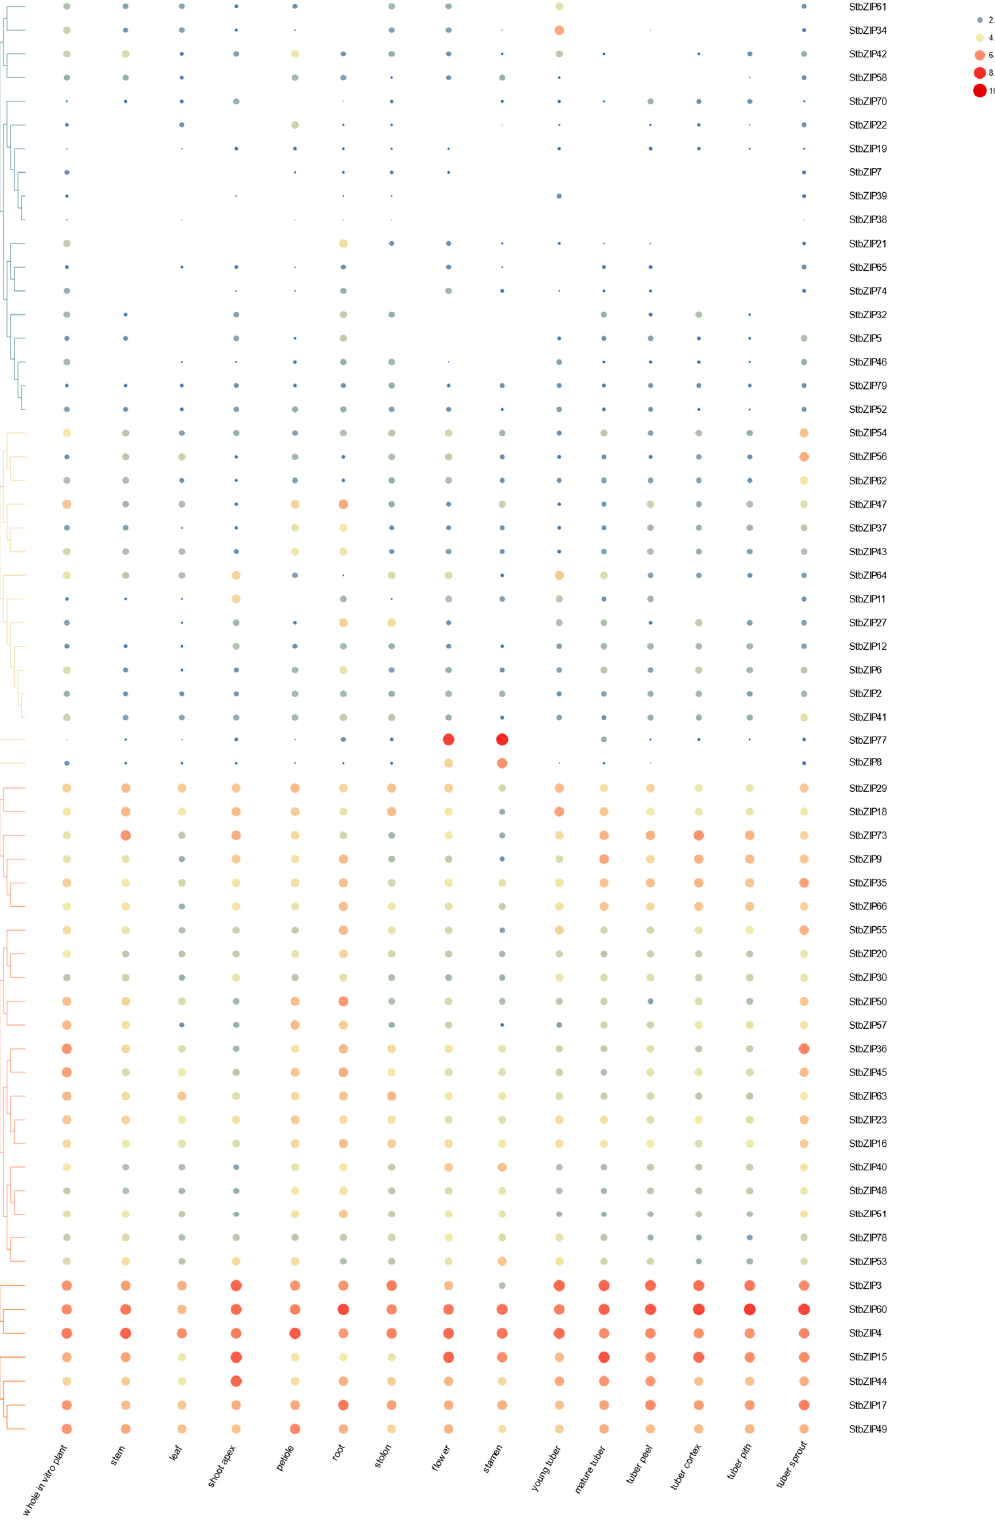
Figure 7. Heat map representation and hierarchical clustering of StbZIP transcript levels across different tissues/organs/developmental stages. The independent gene expression datasets used for this study are provided in Supplementary Table S3. The expression values map to a color gradient from low (blue) to high (red) expression. Values are present using the log2 scale.